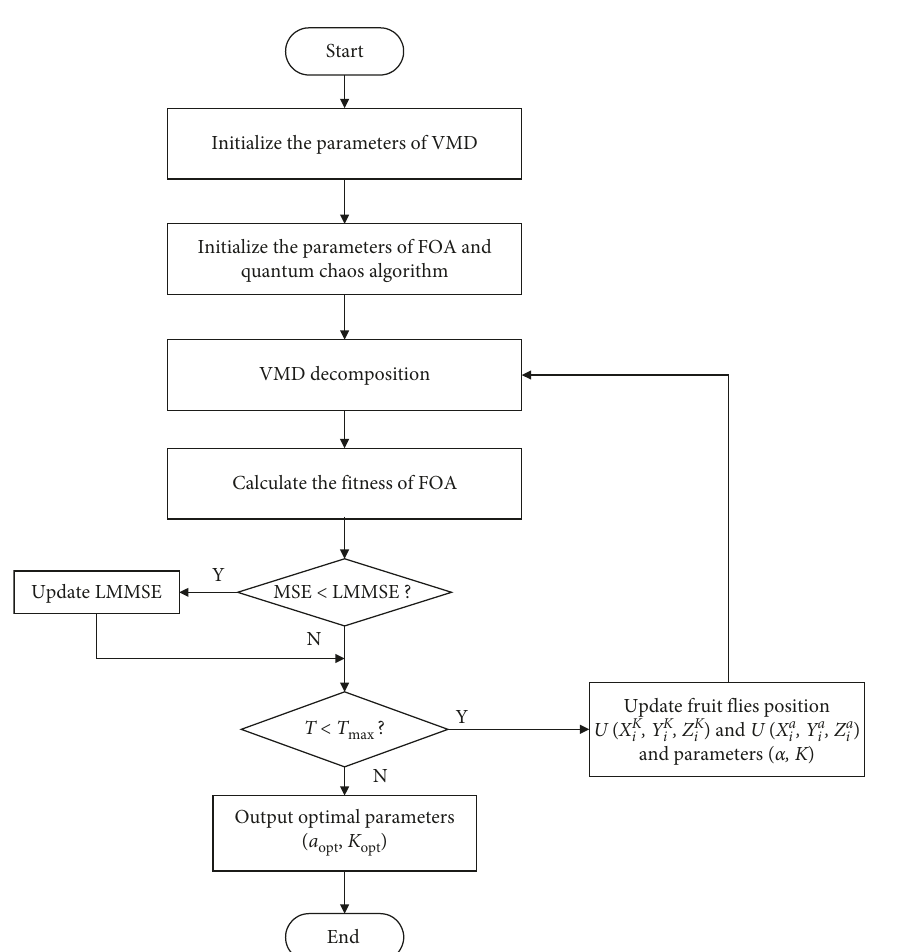
Figure 4: Flow chart of the optimal VMD algorithm. Table 1: Computation efficiency comparison among PSO, QPSO, FOA, CFOA, and QCFOA methods.